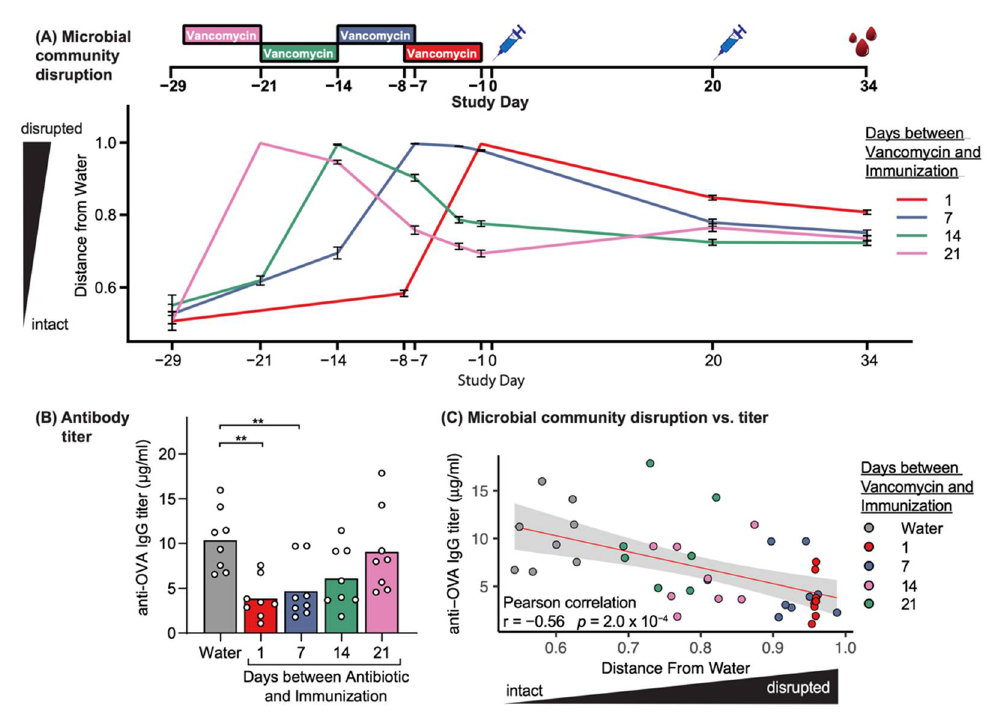
Figure 2. Extended interval between antibiotic treatment and immunization prevents antibiotic-induced vaccine hyporesponse. ( A ) BALB/c mice were orally treated with vancomycin for 7 days (colored rectangles), followed by 1, 7, 14, or 21 days without antibiotic treatment prior to immunization with OVA and VA-510 LNPs on Days 0 and 20 (blue syringes). Harvesting of serum is indicated by red droplets. Fecal samples collected throughout the antibiotic and vaccination phases were subjected to 16s rRNA gene sequencing. The mean microbiome community dissimilarity compared to the average baseline community composition across all groups, calculated using the Bray–Curtis metric and plotted over time. Data are mean and standard error for each treatment group. ( B ) Serum anti-OVA IgG titers were measured at Day 34; measurements from individual mice (circles) are superimposed on group mean (bar). ** p < 0.01 compared to water by one-way ANOVA with Dunnett’s post hoc test. ( C ) Correlation scatter plot of each individual mouse’s OVA-specific IgG titer versus distance between the microbial community composition and the average composition of water-treated animals, measured at Day-1. Red line indicates linear regression line of best fit; gray shading represents 95% confidence interval.